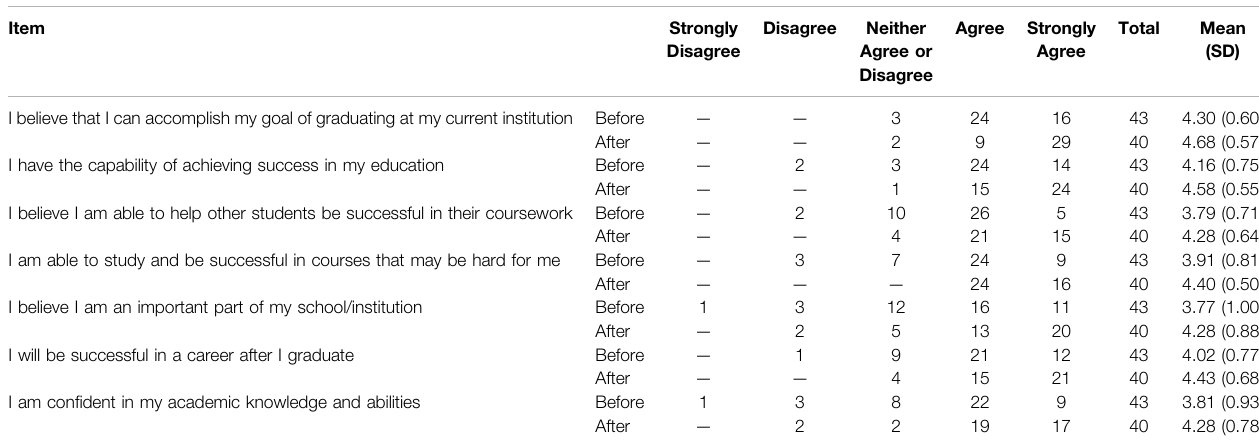
TABLE 3 | Survey items related to academic